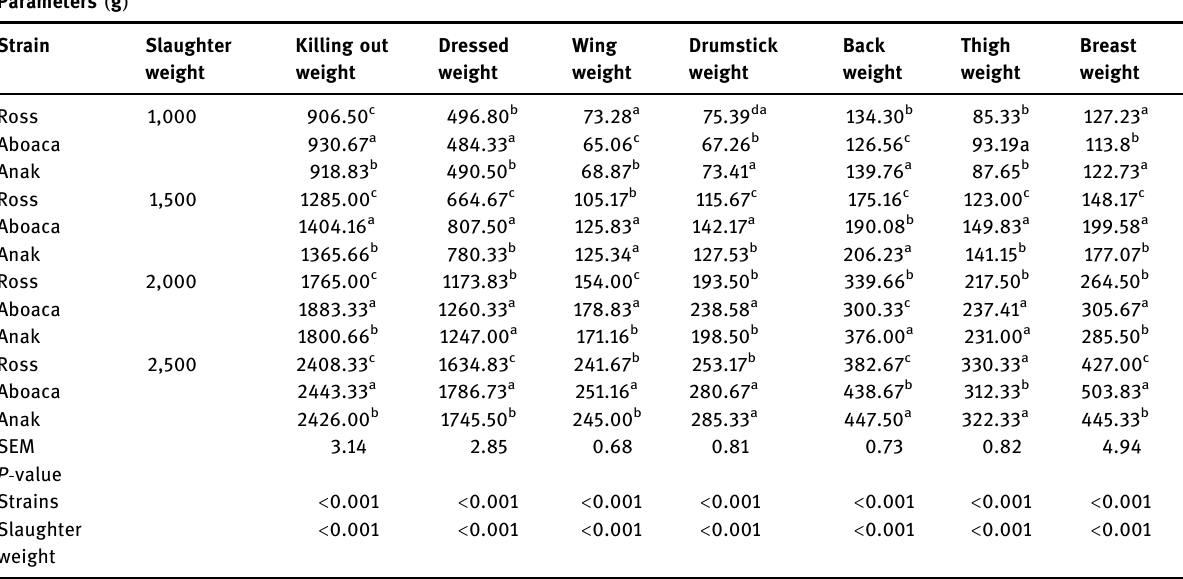
Table 4: Strain and slaughter weight e ff ect on carcass characteristic of three commercial broiler chickens Parameters ( g